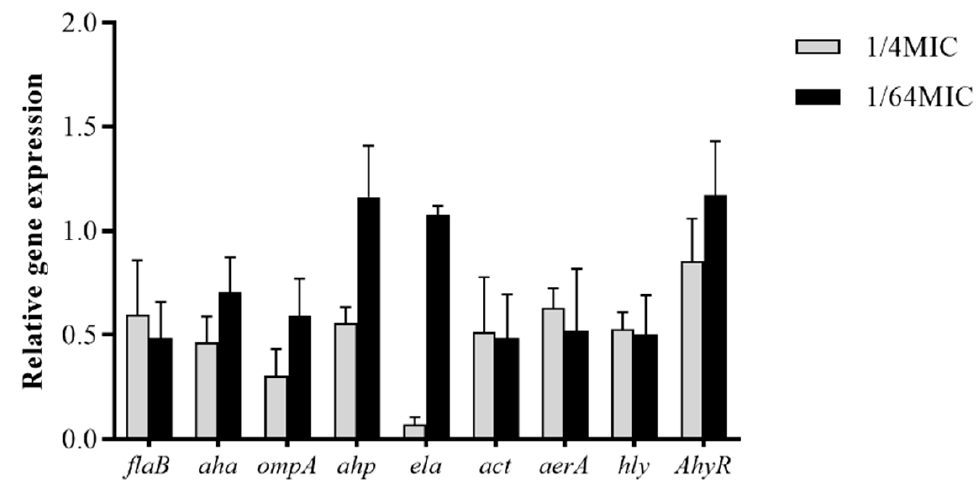
Figure 4. Effect of carvacrol on the virulence gene expression in A. hydrophila. Data are shown as the value of the carvacrol treated (1/4 MIC, 1/64 MIC) group divided by that of the DMSO (negative control) group. Data are presented as the mean ± standard error (SE) of three independent